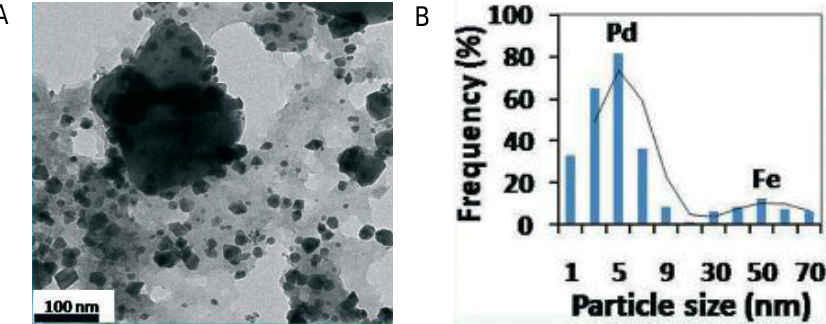
Figure 12. Characterization of Fe-Pd NPs synthesized by Ulmus davidiana. ( A ) TEM image of Fe-Pd NPs; ( B ) Particle size distribution histogram. Reproduced with permission from [12]. Copyright the Royal Society of Chemistry, 2015.